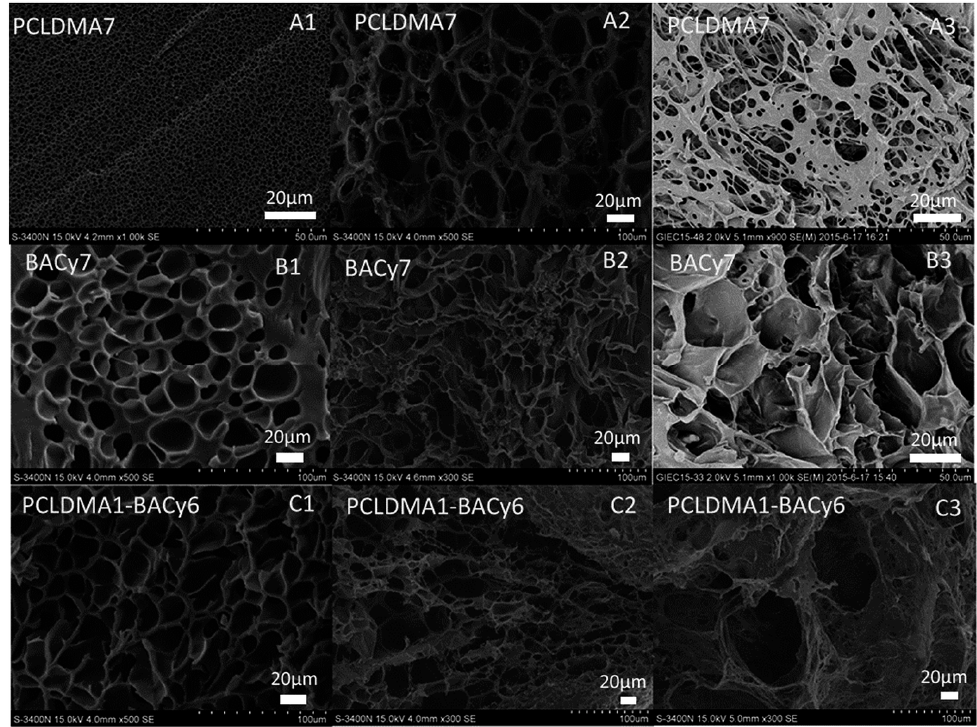
Figure 12. SEM micrographs of degraded ( A1 – A3 ) PNIPAAm- co -PCLDMA copolymer, ( B1 – B3 ) PNIPAAm- co -BACy, and ( A3 – C3 ) PNIPAAm- co -PCLDMA- co -BACy at ( A1 – C1 ) 0 days, ( A2